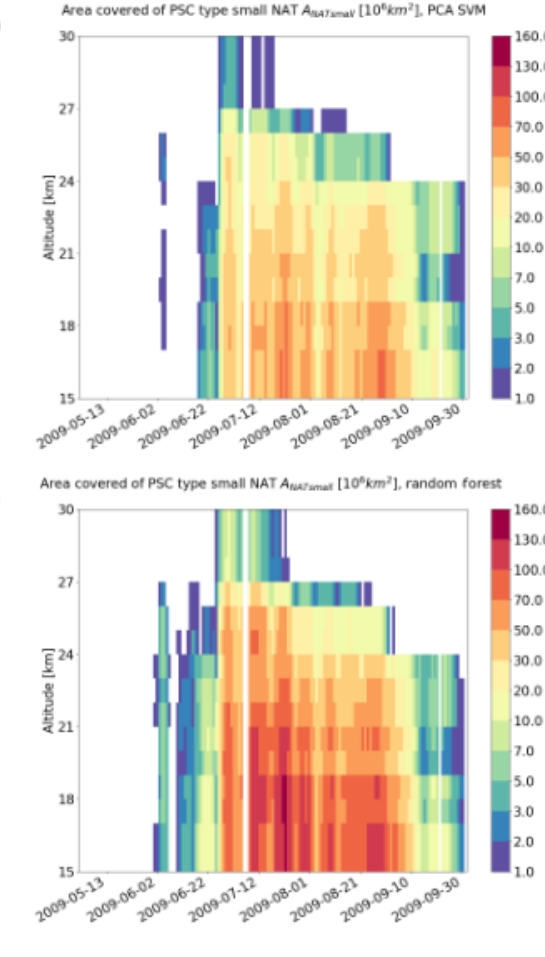
Figure 13. Same as Fig. 11 but for